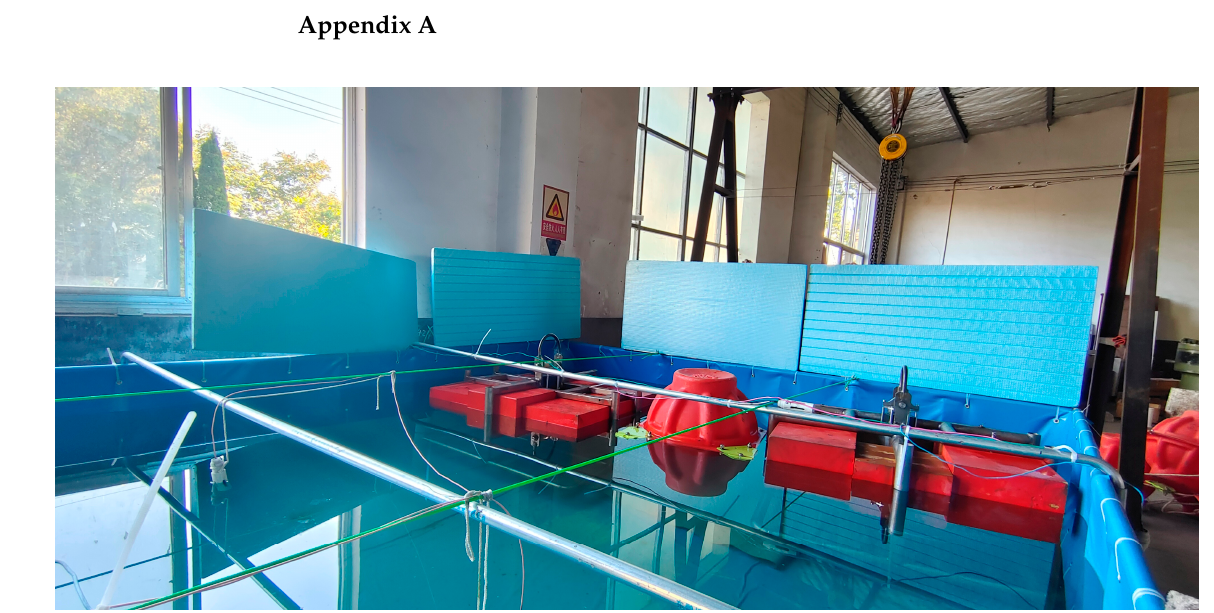
Figure A1. Water tank experiment.